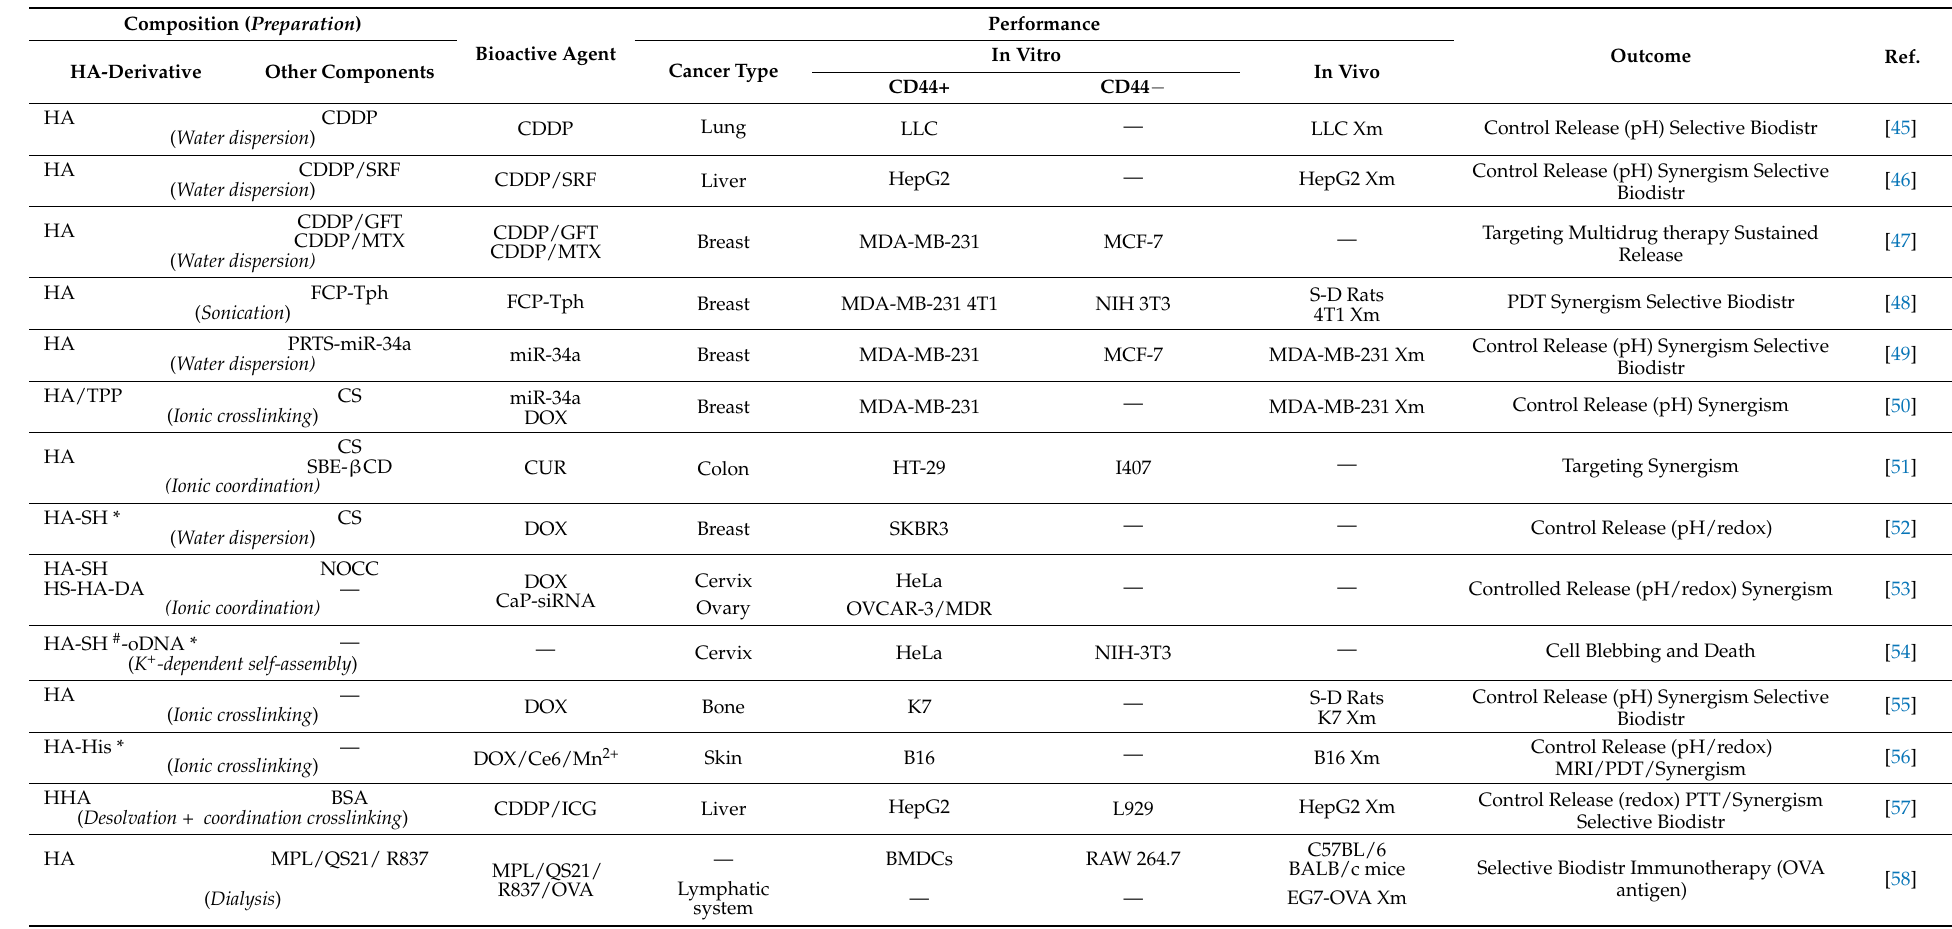
Table 1. HA-SANPs obtained by electrostatic